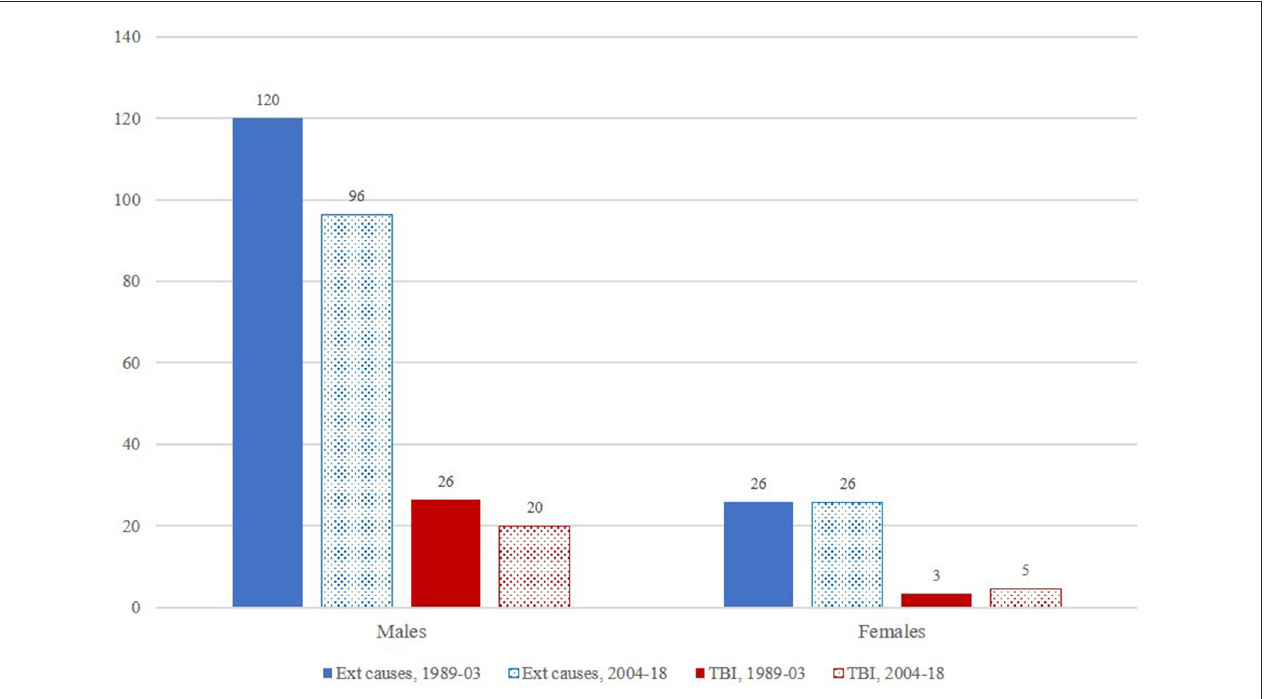
FIGURE 1 | Age-standardised mortality rates for all external causes (including TBIs) and TBI-related deaths only, according to sex and period.